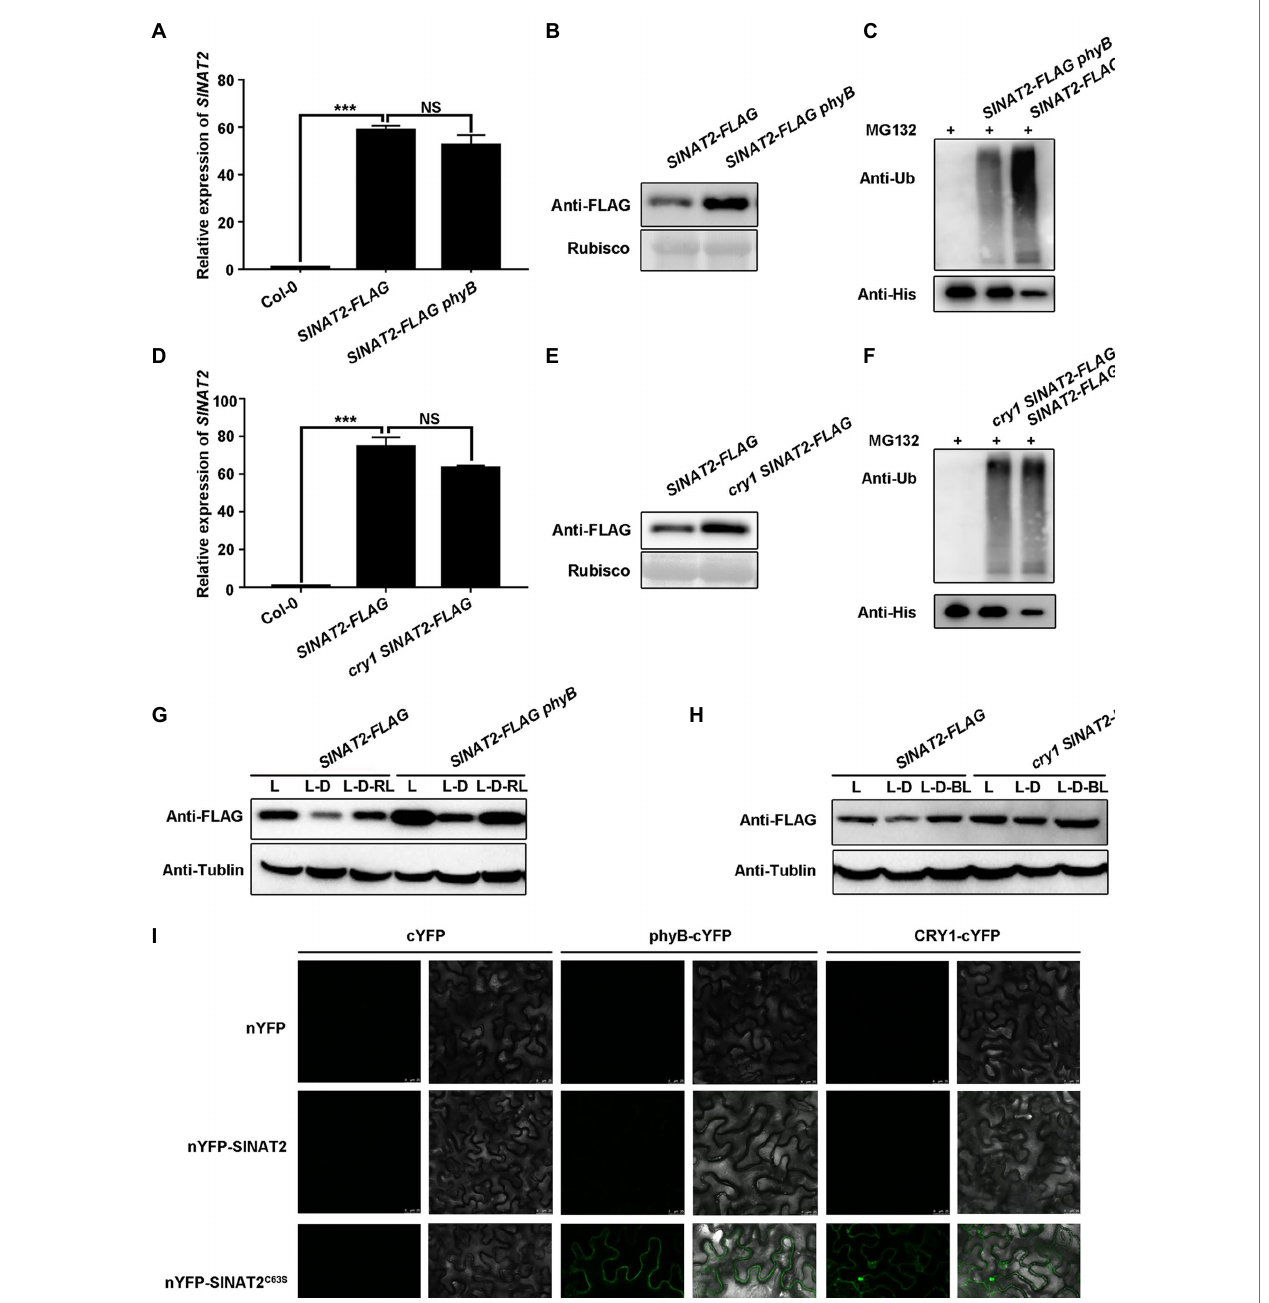
FIGURE 3 | phyB and CRY1 promote SINAT degradation. (A) SINAT2 transcript levels in Col-0, SINAT2-FLAG , and SINAT2-FLAG phyB plants. Data are means ± SD ( n = 3) and values of p were determined by Student’s t -test; *** p < 0.001; NS, non-significant, p > 0.05. (B) SINAT2 protein levels in SINAT2-FLAG and SINAT2-FLAG phyB plants. Rubisco was used as a loading control. (C) Detection of His-SIANT2 ubiquitination in the semi- in vivo ubiquitination assays. Recombinant His-SIANT2 protein was incubated with protein extracts from the SINAT2-FLAG and SINAT2-FLAG phyB plants. His-SIANT2 and His-SIANT2- Ub proteins were detected by Western blotting with anti-Ub antibodies (upper gels) and anti-His antibodies (lower gels). (D) SINAT2 transcript levels in Col- 0, SINAT2-FLAG , and cry1 SINAT2-FLAG plants. Data are means ± SD ( n = 3) and values of p were determined by Student’s t -test; *** p < 0.001; NS, non- significant, p > 0.05. (E) SINAT2 protein levels in SINAT2-FLAG and cry1 SINAT2-FLAG plants. (F) Detection of His-SIANT2 ubiquitination in the SINAT2- FLAG and cry1 SINAT2-FLAG plants. (G) The effect of red light on SINAT2 protein levels in SINAT2-FLAG and phyB SINAT2-FLAG plants. Five-day-old plants grown under continuous light (L) were transferred to the dark for 6 h (L-D) and were then transferred to red light for a further 6 h (L-D-RL). (H) The effect of blue light on SINAT2 protein levels in SINAT2-FLAG and cry1 SINAT2-FLAG plants. Five-day-old plants grown under continuous light (L) were transferred to the dark for 6 h (L-D) and were then transferred to blue light for a further 6 h (L-D-BL). (I) Interaction of SINAT2 C63S with phyB and CRY1 in BiFC